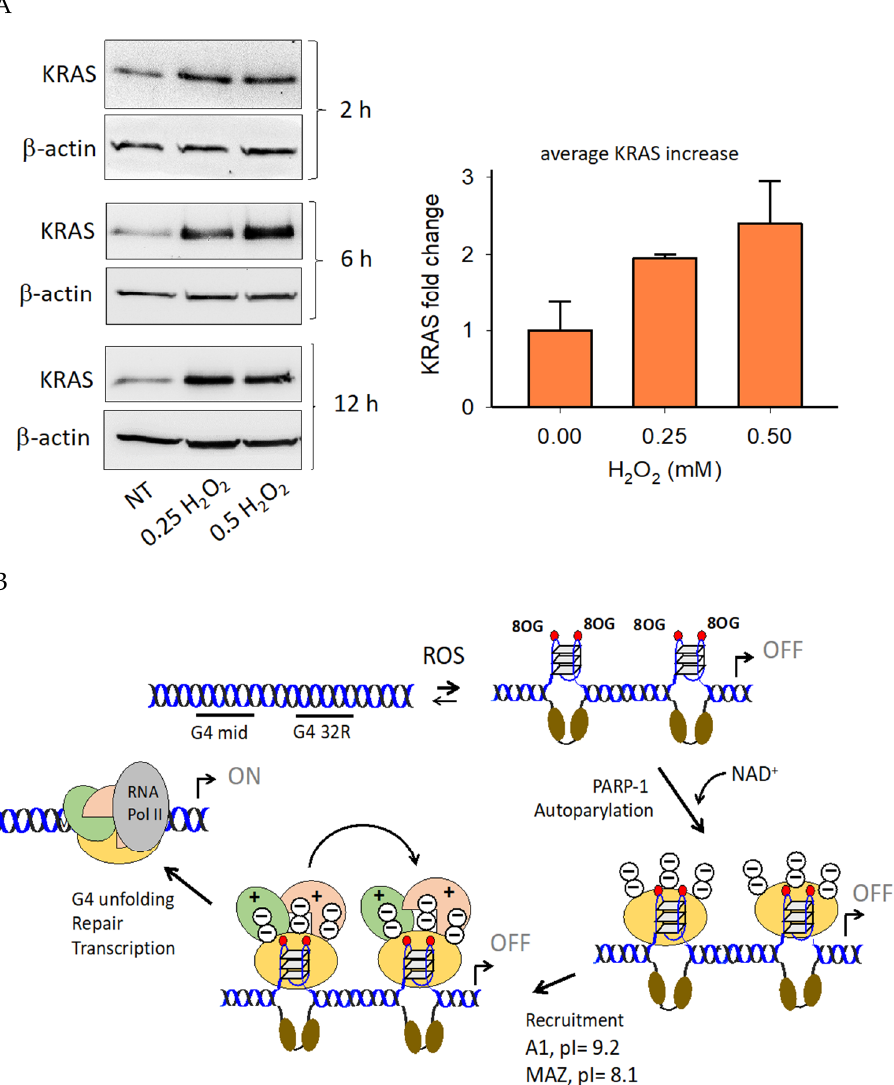
Figure 8. ( A ) Western blots of lysates obtained from Panc-1 cells treated with 0, 0.25, and 0.5 mM H 2 O 2 for 2, 6, and 12 h. The cell lysates were obtained to determine the level of expressed KRAS protein respect to β -actin. Band density was assessed with ImageJ Software. The bar plot, reporting the average KRAS / β -actin values from the three treatments, shows that KRAS transcription is stimulated by ROS; ( B ) Proposed mechanism of KRAS activation caused by an increase of oxidative stress. A1 = hnRNP A1, pI = isolectric point.